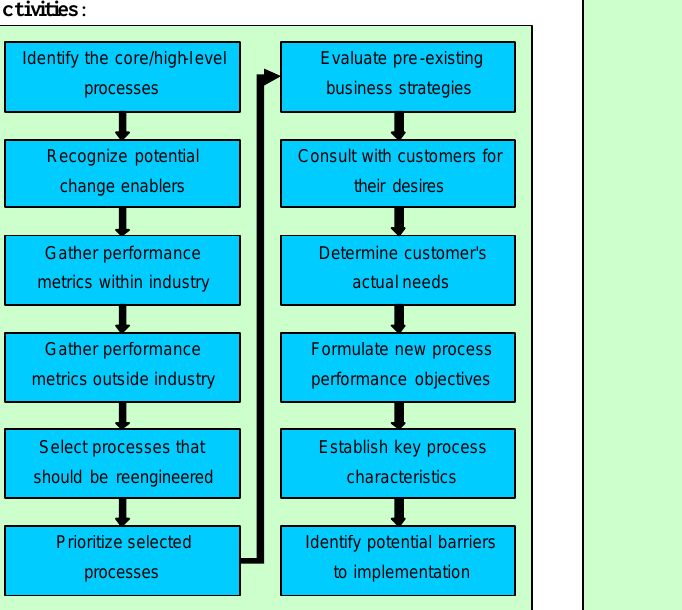
Figure 2: Activities Performed in Phase 2 Phase 3: Identify BPR Opportunities